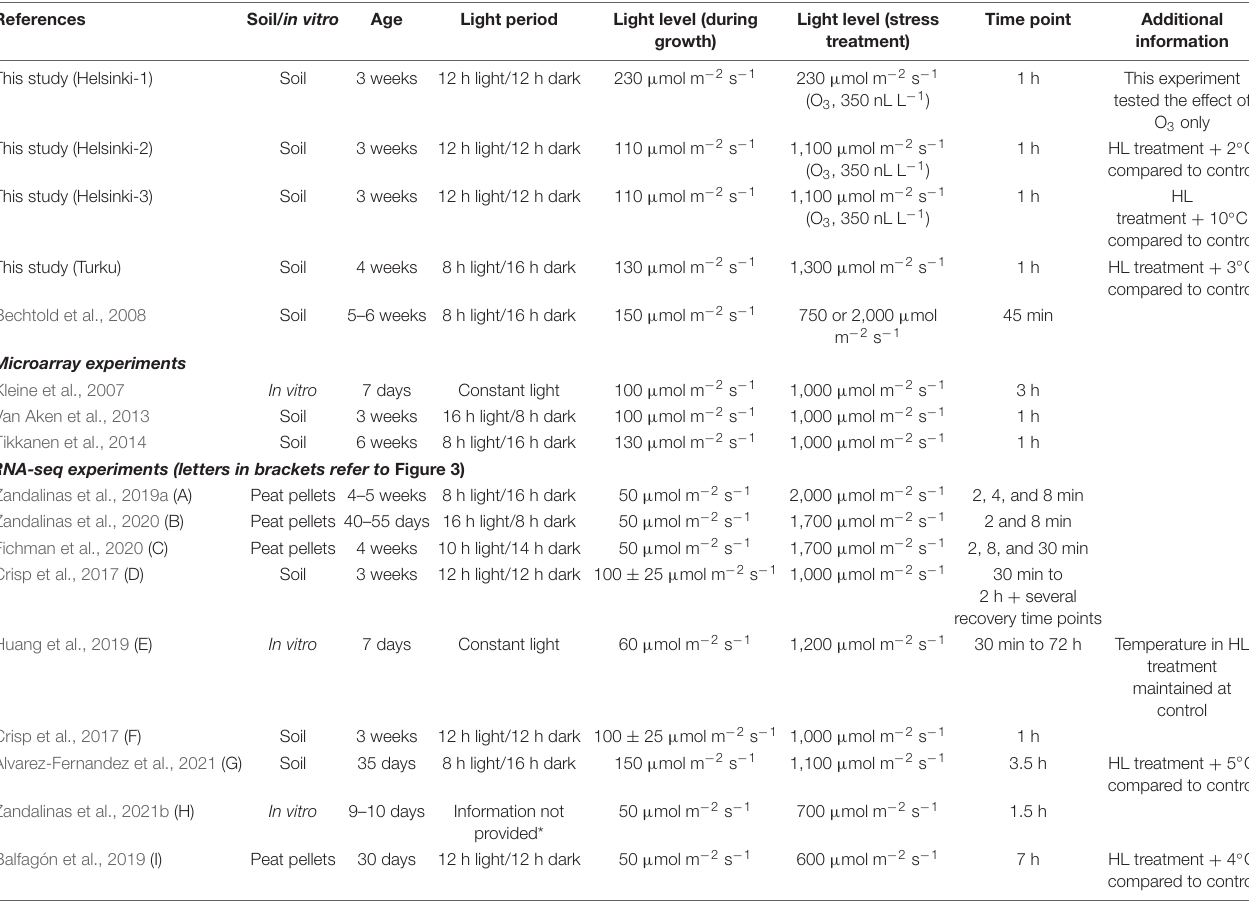
TABLE 1 | Growth conditions used for Arabidopsis HL experiments and transcriptome analysis with qPCR, microarrays or